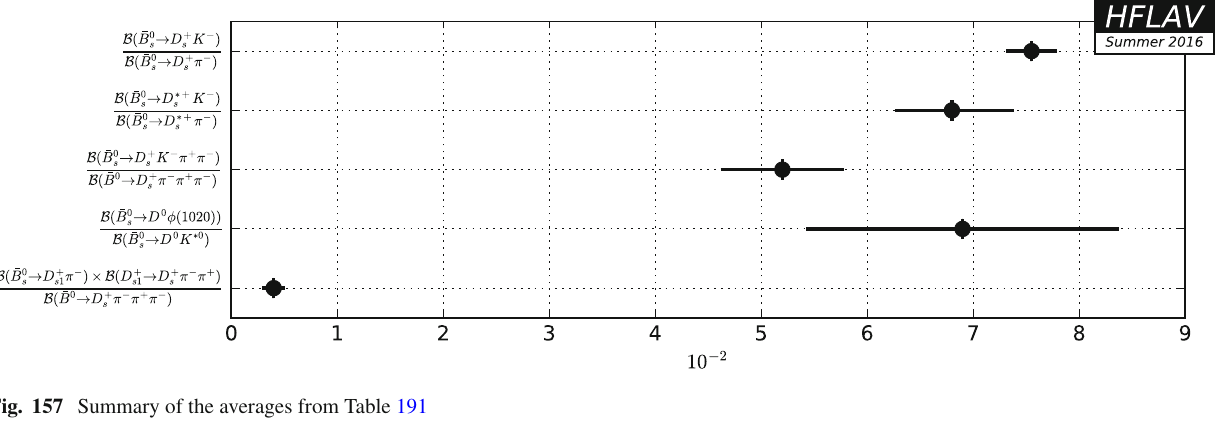
Fig. 157 Summary of the averages from Table 191